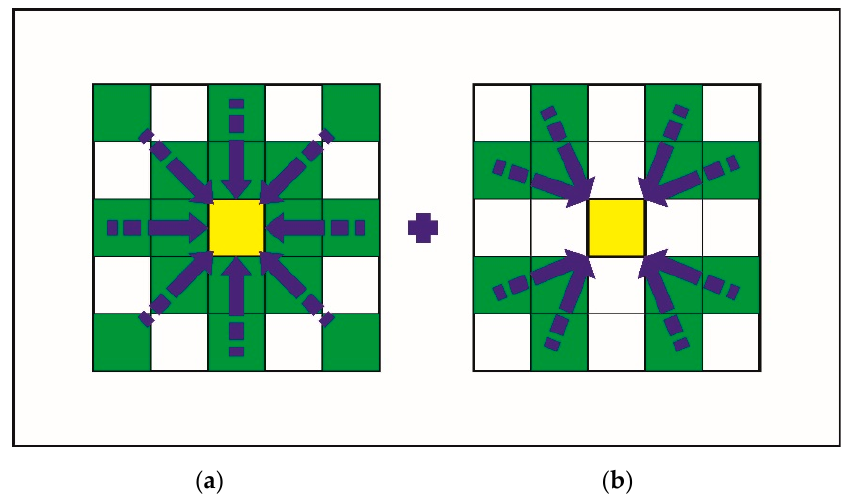
Figure 6. The representation of the 360° field of view by the 16 scenic valuation directions comprising the short-range viewshed; ( a ) Main (straightforward) scenic valuation directions; ( b ) Auxiliary (completing) scenic valuation directions. Green cells are those whose habitat features and aesthetic appeal values are accounted for in the sub-process of computation. (Drawn by Arvydas Urbis).